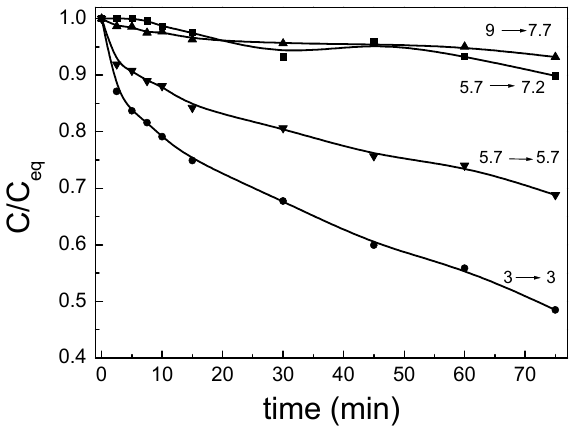
Figure 8. Kinetics of 500 µ g / L SMX adsorption as a function of solution pH with 200 mg / L biochar. For each experiment, the starting and final pH values are indicated.